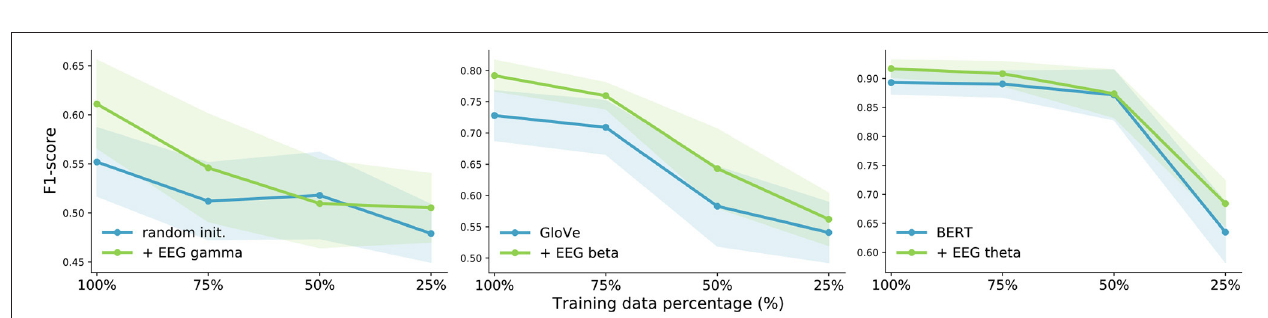
FIGURE 5 | Data ablation for all three word embedding types for the binary sentiment analysis task using the convolutional EEG decoding component . The shaded areas represent the standard